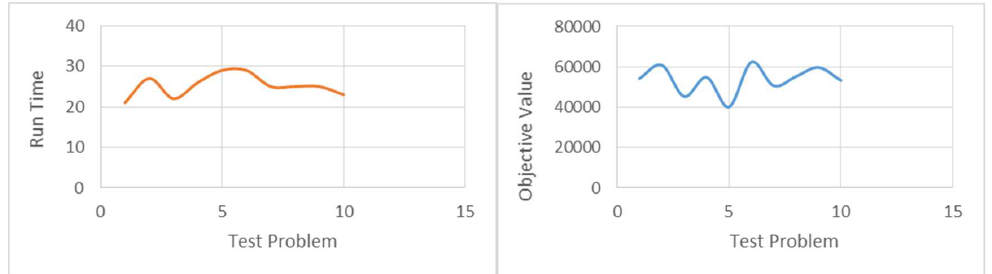
Fig. 17. Objective value and run time for scenario